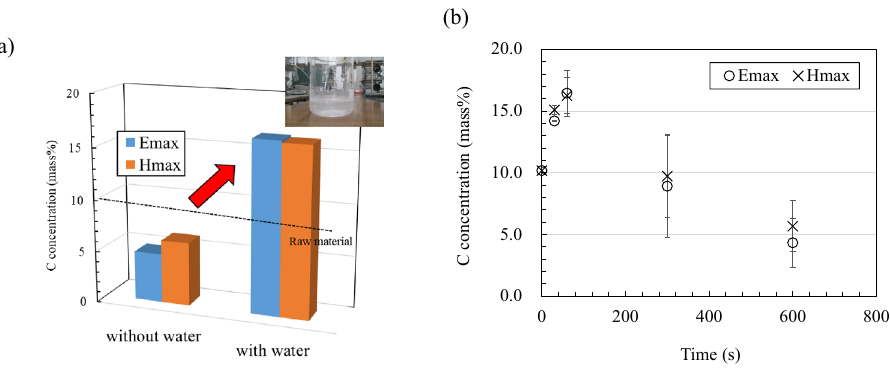
Figure 3. ( a ) Comparison of carbon concentration in the mixture with or without added water after heating with microwave electric field and magnetic field and ( b ) the sintering time dependence of carbon concentration in the sintered body.